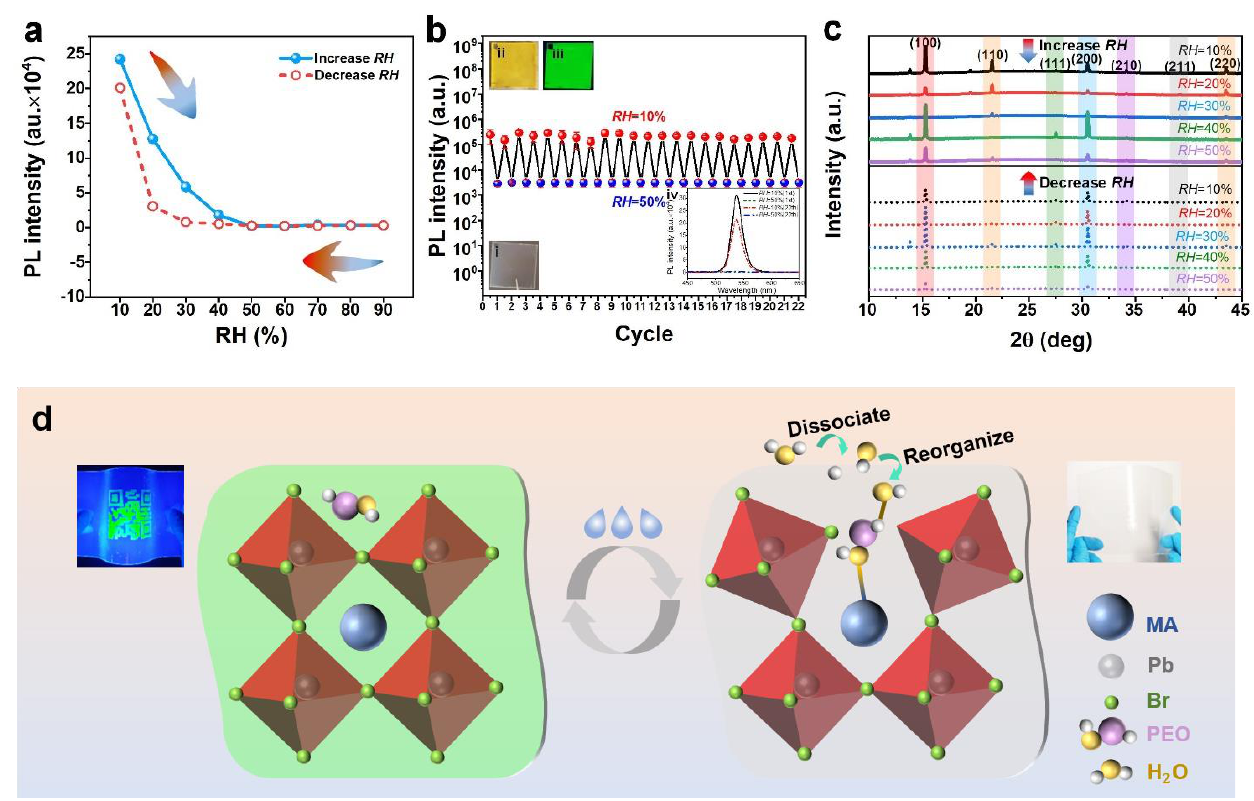
Figure 3. PL sensitivity and mechanism of PPC material. ( a ) PL spectra of PPC film under a single humidity cycle (the RH of 10%~90%). ( b ) The change of PL intensity with 22 cycles in reversible humidity (Note: a cycle of 10 samples). Inset: (i) Natural light photos under 50% humidity, (ii) Natural light and (iii) UV photos under 10% humidity, (iv) The PL spectra of initial PPC film and that after several humidity cycles. ( c ) XRD of PPC film in increase and decrease of humidity under the RH of 10%~50%, respectively. ( d ) Schematic illustration of the mechanism of fluorescence reversibility of PPC materials.